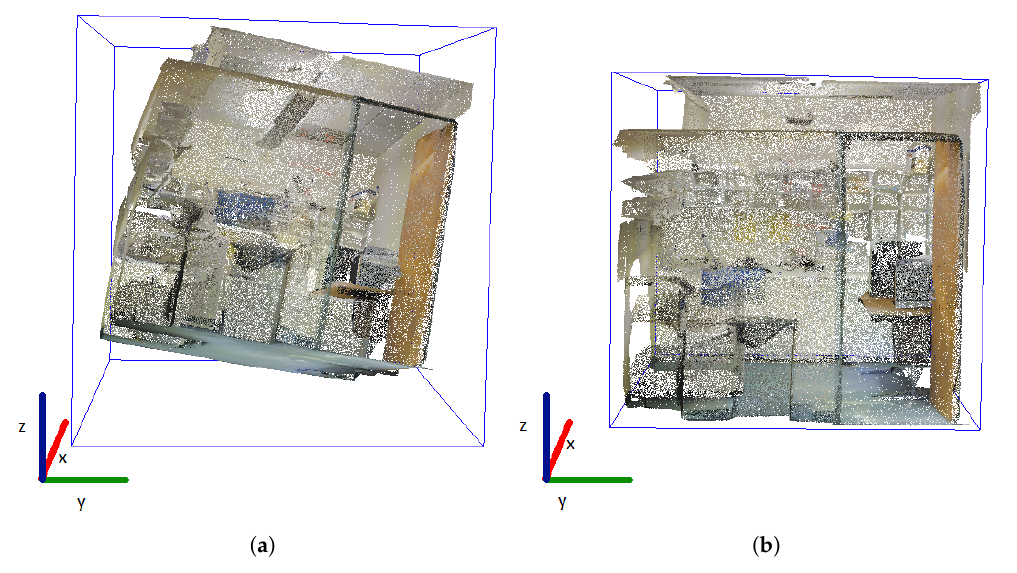
Figure 3. ( a ) Misaligned point cloud ( b ) aligned point